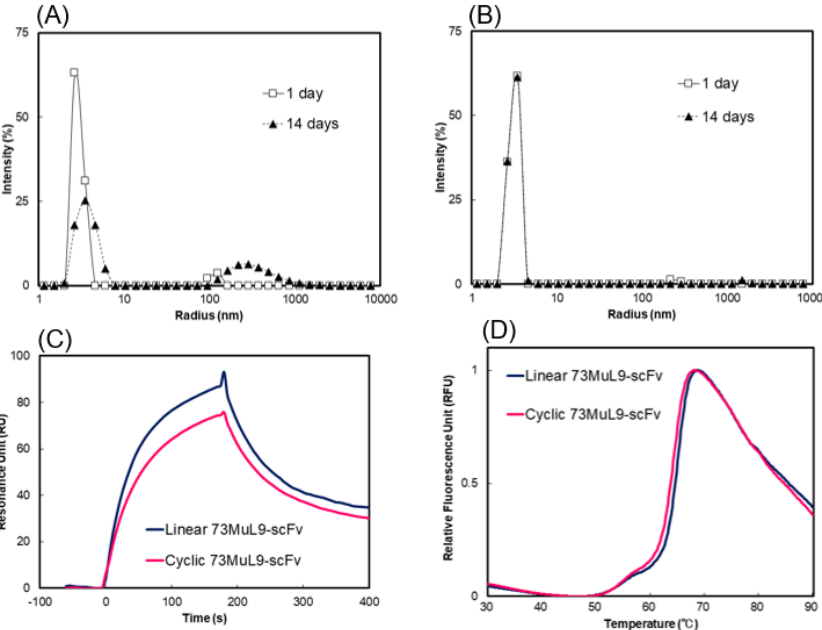
Figure 6. Characterization of cyclic 73MuL9-scFv. ( A ) Molecular size distributions by DLS analysis. Linear 73MuL9-scFv ( A ) and cyclic 73MuL9-scFv ( B ) were concentrated to 3 mg/mL, and incubated at 4 °C for 1 day (solid line) or 14 days (dashed line). ( C ) SPR analysis of the binding affinity for the peptide containing GA-pyridine at 25 °C for linear (blue) and cyclic 73MuL9-scFv (magenta). ( D ) DSF analysis of the thermal stability of linear (blue) and cyclic 73MuL9-scFv (magenta).